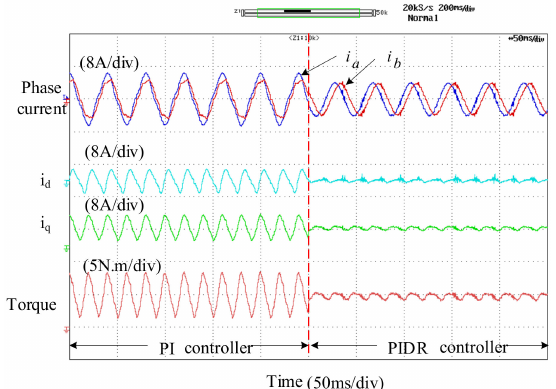
Figure 11. The experimental comparison before and after the application of the proposed PIDR controller.